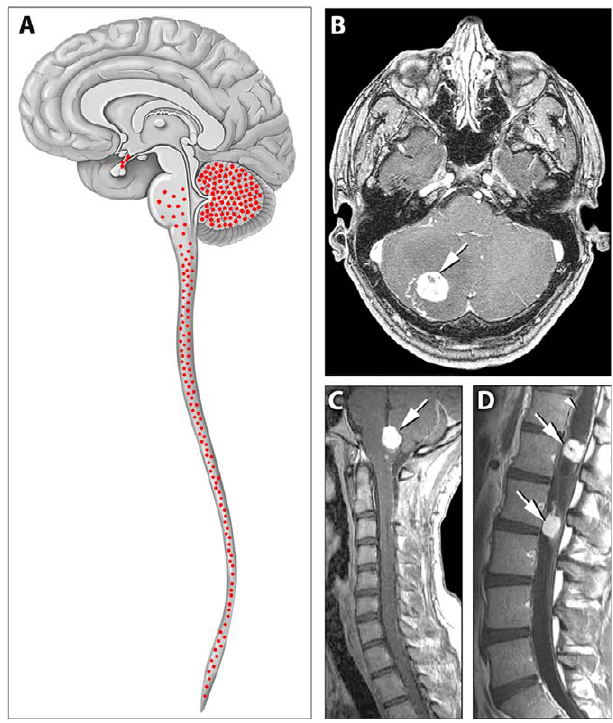
Figure 1. Distribution of Hemangioblastomas in the Central Nervous Systems of Study Patients (A) Schematic representation of the distribution of CNS hemangioblas- tomas (red dots) in the 25 von Hippel-Lindau disease patients on MRI. Most (98%) of hemangioblastomas were found below the level of the tentorium in the cerebellum, brainstem, and spinal cord. (B–D) Contrast-enhanced MRI demonstrating representative locations of hemangioblastomas including the cerebellum (B), brainstem (C) and spinal cord (D). (B) Axial view through the cerebellum demonstrating a hyperintense enhancing hemangioblastoma (arrow) with surrounding edema (hypointense area surrounding the tumor) that frequently is associated with these lesions. (C) Sagittal view through the posterior fossa demonstrating a hyperintense enhancing brainstem (medullary) hemangioblastoma (arrow) with surrounding edema. (D) Sagittal view through the thoracic and lumbar spinal cord demonstrating two hyperintense enhancing hemangioblastomas (arrows). The superior tumor is associated with a large intraspinal cyst (syrinx) that is common with these neoplasms